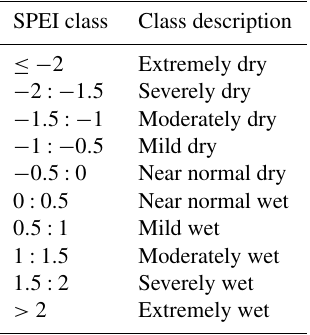
Table 1. Classification of SPEI values (based on Edossa et al.,